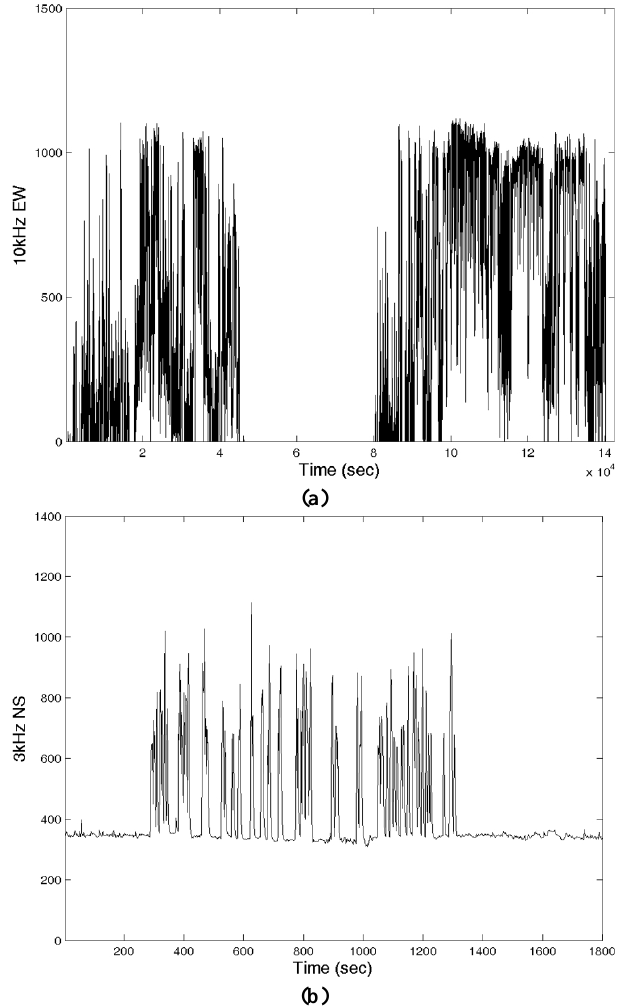
Fig. 5. Recordings of the magnetic field strength (in arbitrary units) from Zante station: strong burst-like EM emissions emitted just be- fore the EQ occurrence (a) at 10kHz (direction East–West) before the Athens’ EQ ( M W = 5 . 9, 7 September 1999) (above the back- ground noise level, please refer to the blue frame in Fig. 4), and (b) at 3kHz (direction North–South) before the Kozani–Grevena EQ ( M W = 6 . 6, 13 May